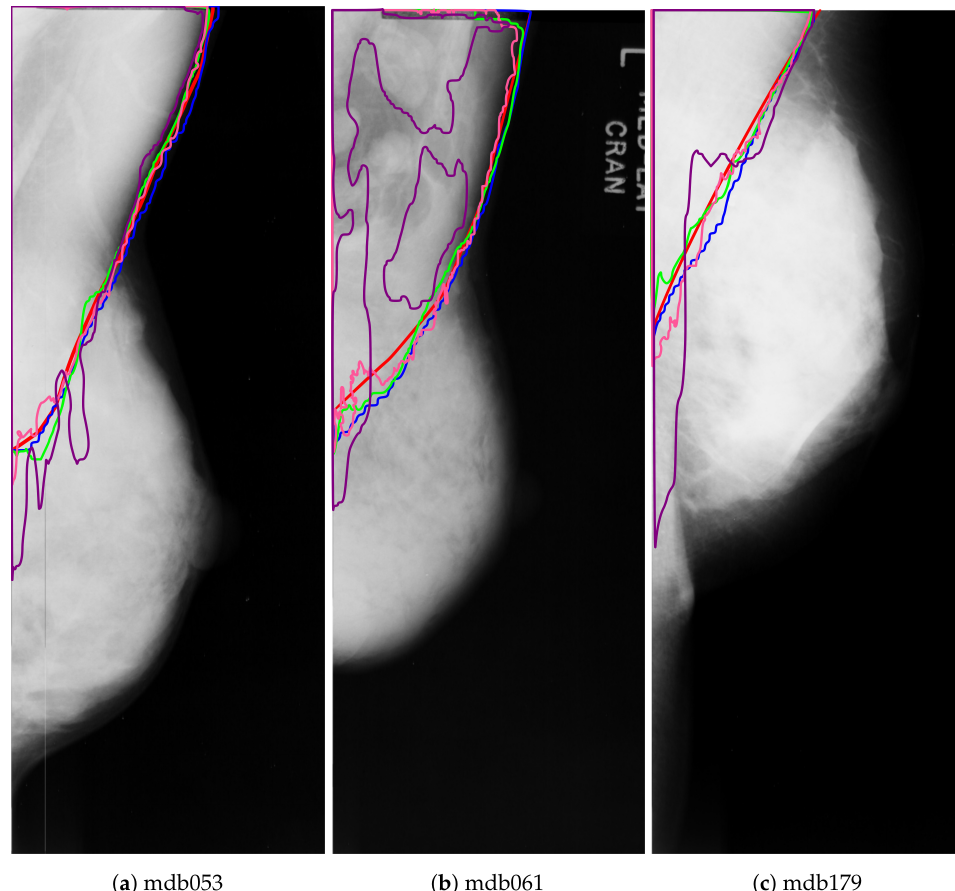
Figure 16. Pectoral muscle segmentation for the dense class using the different DNNs: ground truth (red), ResNet50+PSPNet (blue), ResNet50+U-Net (green), VGG+FCN8 (pink), and VGG+U-Net